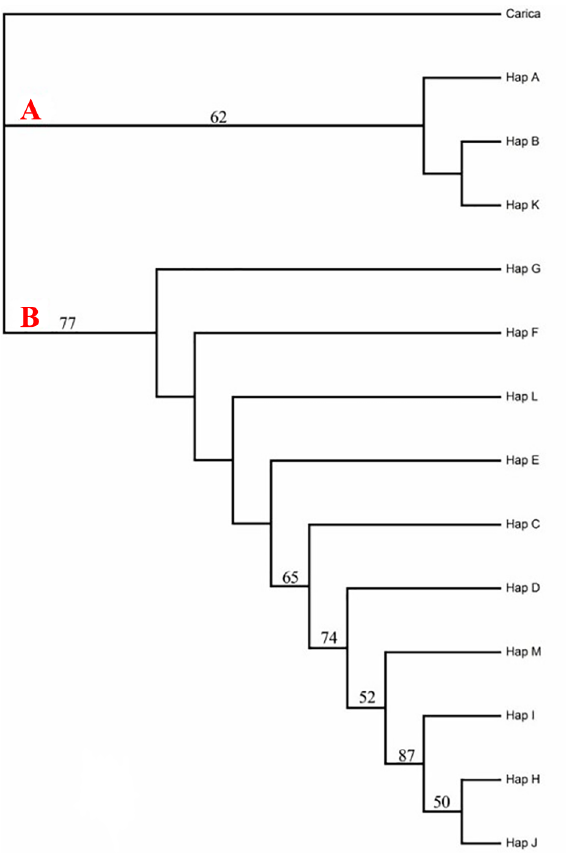
Fig 2. Neighbor-joining tree for haplotypes of Bretschneidera sinensis in China. Neighbor-joiningtree of 13 haplotypes (including cpDNA SSRs) of B . sinensis .Note: Red letters A and B stand for different clades. Bootstrap values (higher than 50) are given above the